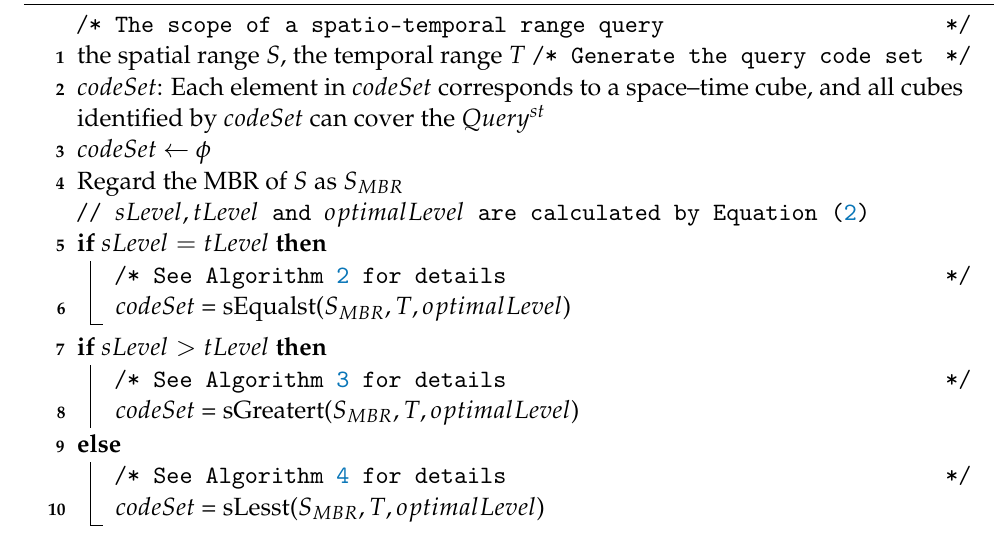
Algorithm 1: Adaptive spatio-temporal scaling and coding method based on HGST